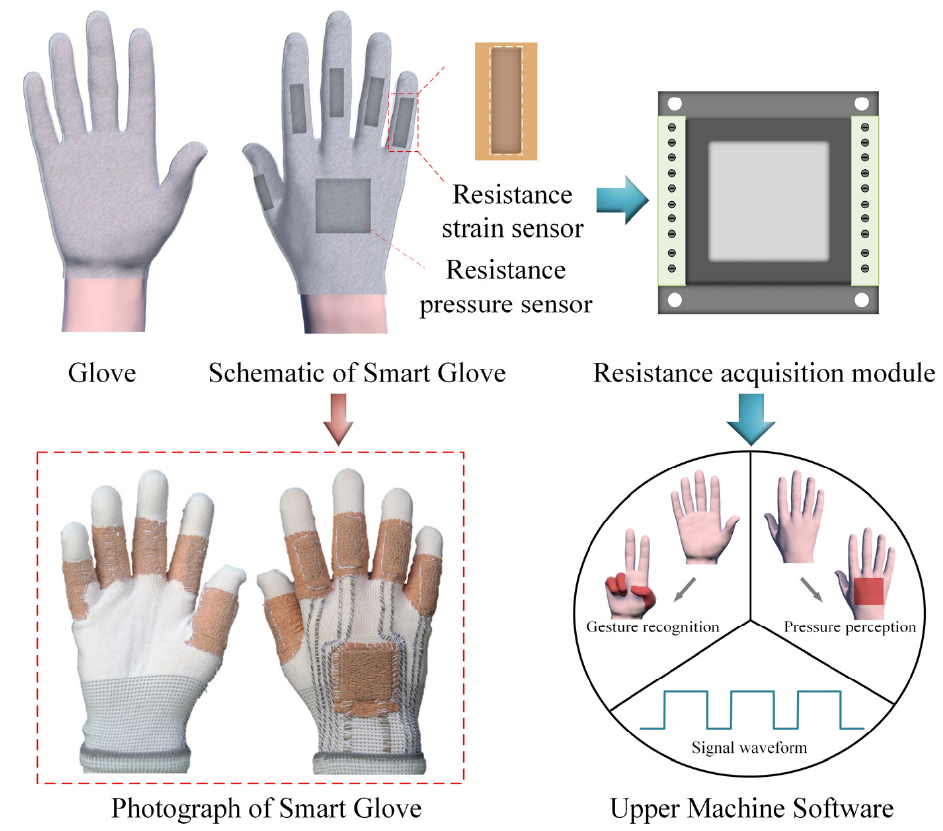
Figure 3. Integration of the resistive sensors with a smart glove for gesture recognition and perception detection.